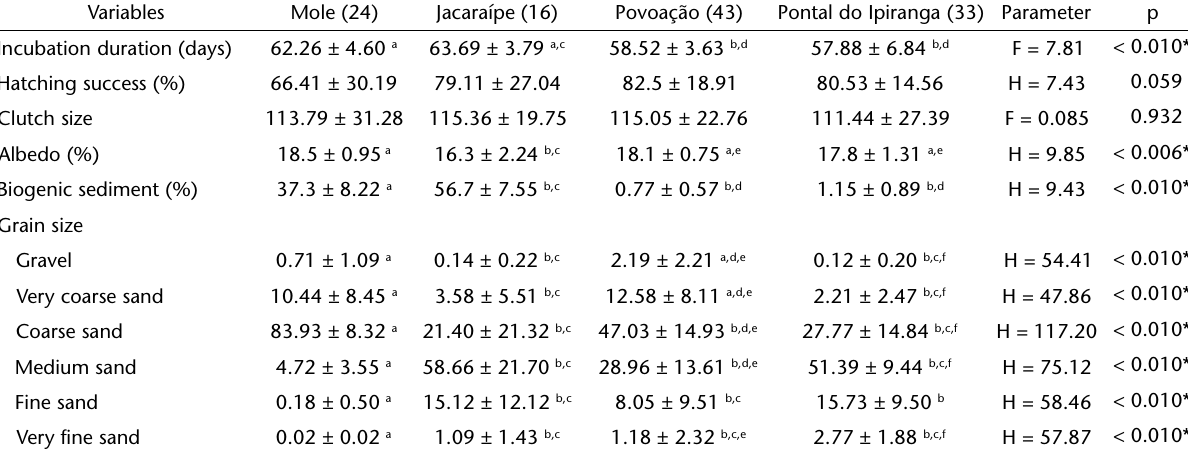
Table I. Variation of biological and environmental factors across the nesting sites of C. caretta during the 2006/2007 reproductive season. Mean ± standard deviation (sample size) * and means, followed by distinct letters at the same position, denote significance at the 0.05 level.